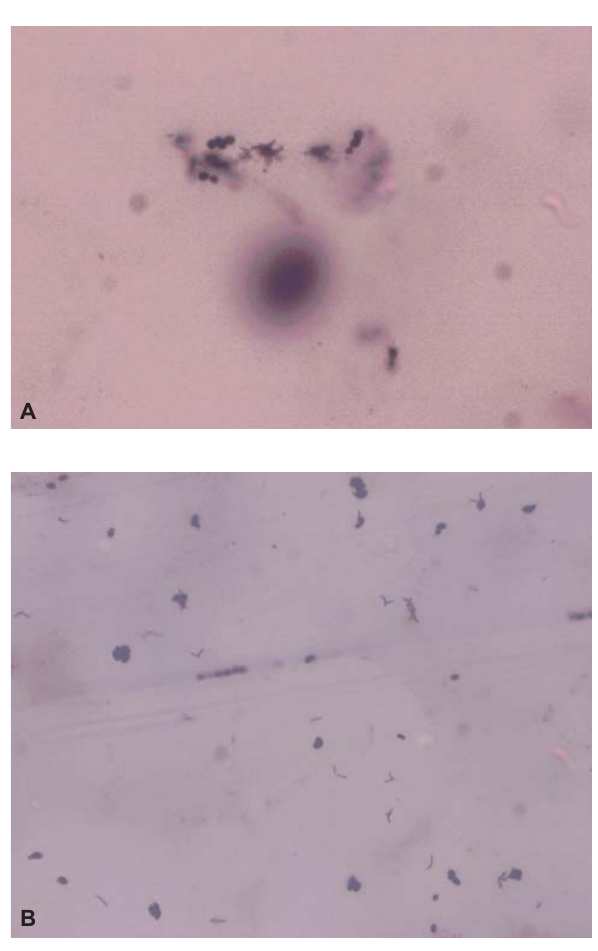
FIGURE 2A and B- Adherence of Candida albicans and bacteria on a soft denture liner coated with